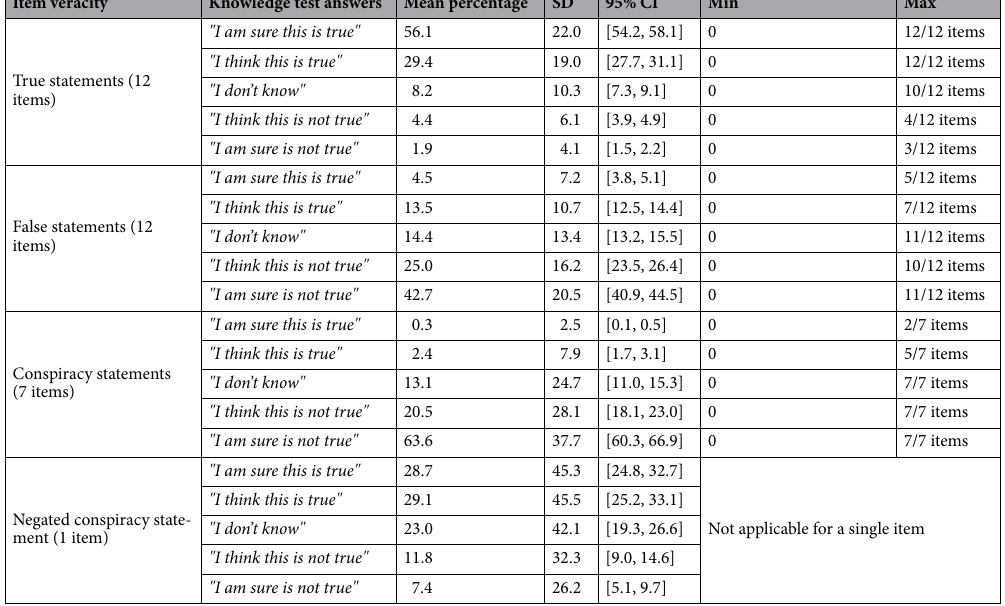
Table 3. Descriptive statistics COVID-19 knowledge test (N =